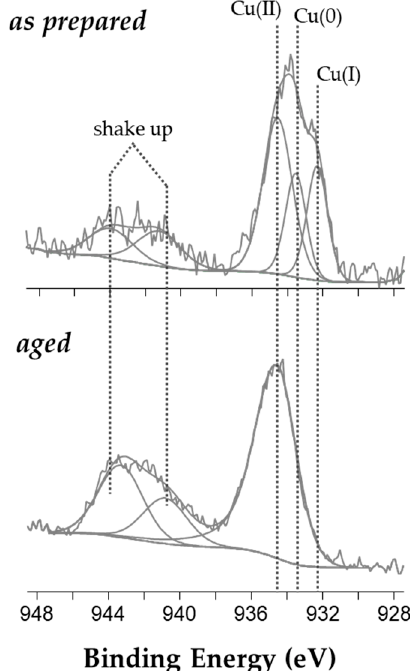
Figure 2. Cu2p 3 / 2 XP high resolution spectra of as-prepared and 29-day-old Figure 2. Cu2p 3/2 XP high resolution spectra of as-prepared and 29-day-old CuNPs@BAC.